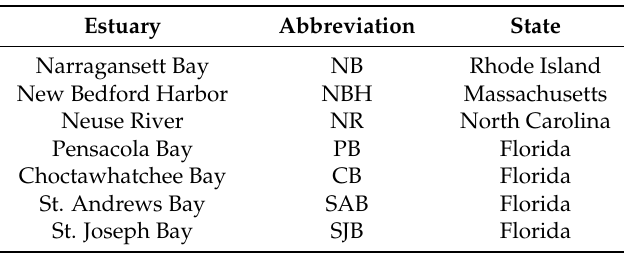
Table 1. Estuaries sampled during this